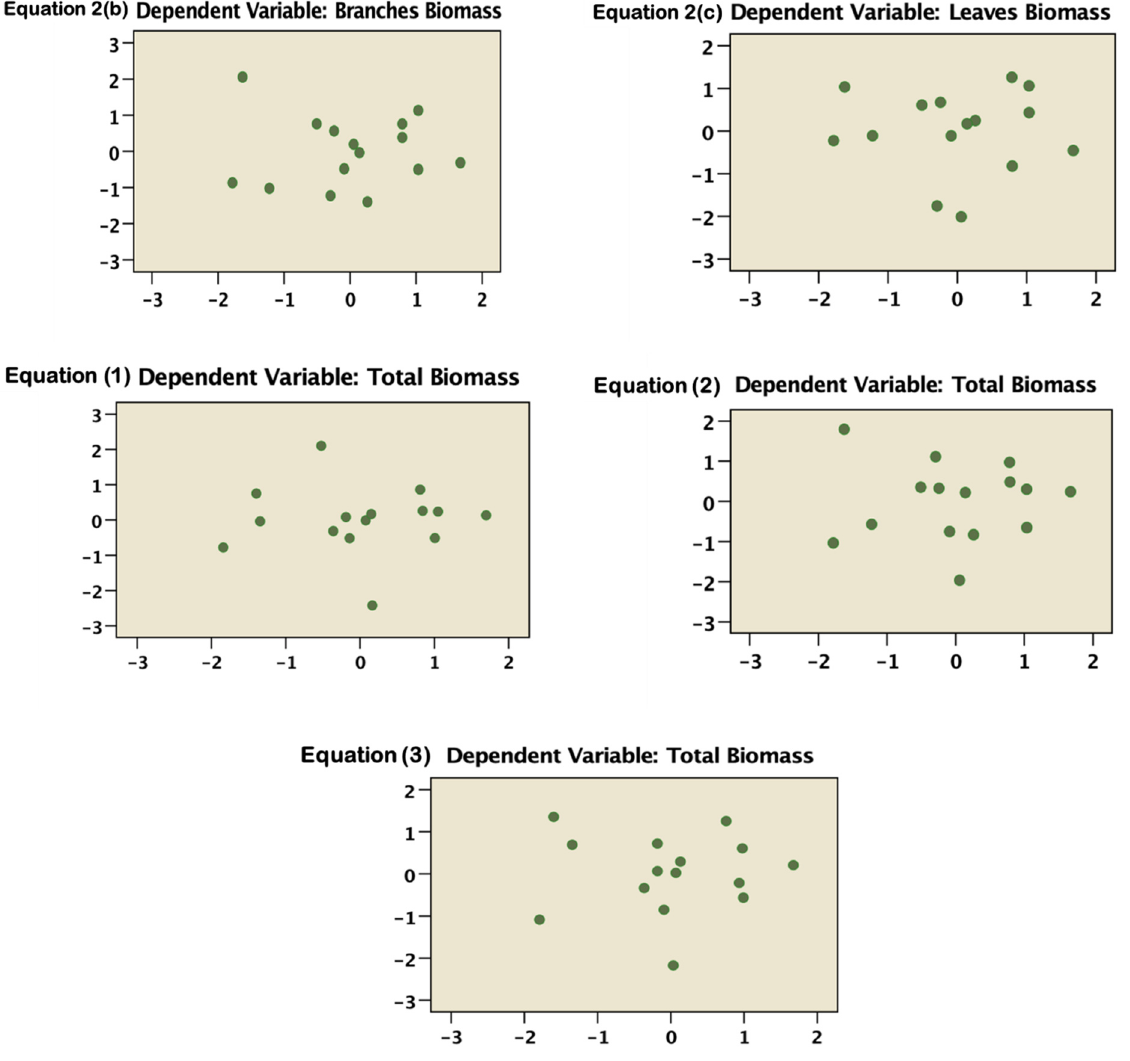
Figure 2. The test of homoscedasticity of residuals.